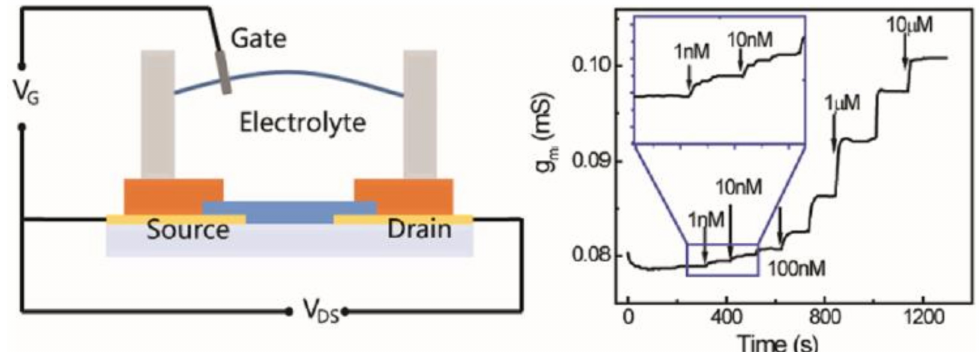
Figure 15. Schematic diagram of an OECT cross-section and the wiring system for device operation ( right ). Channel transconductance (gm) to additions of dopamine with different concentrations ( left ). Reprinted with permission from [143]. Copyright 2017 American Chemical